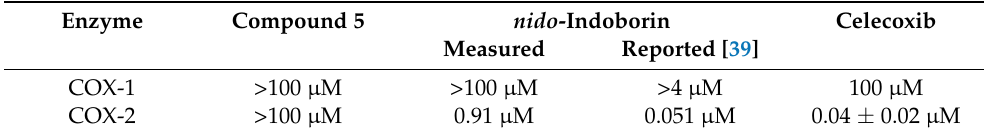
Table 1. IC 50 values of compound 5 and nido -indoborin for the inhibition of COX-1 and COX-2. Tested with the commercial “COX Fluorescent Inhibitor Screening Assay Kit” from Cayman Chemical